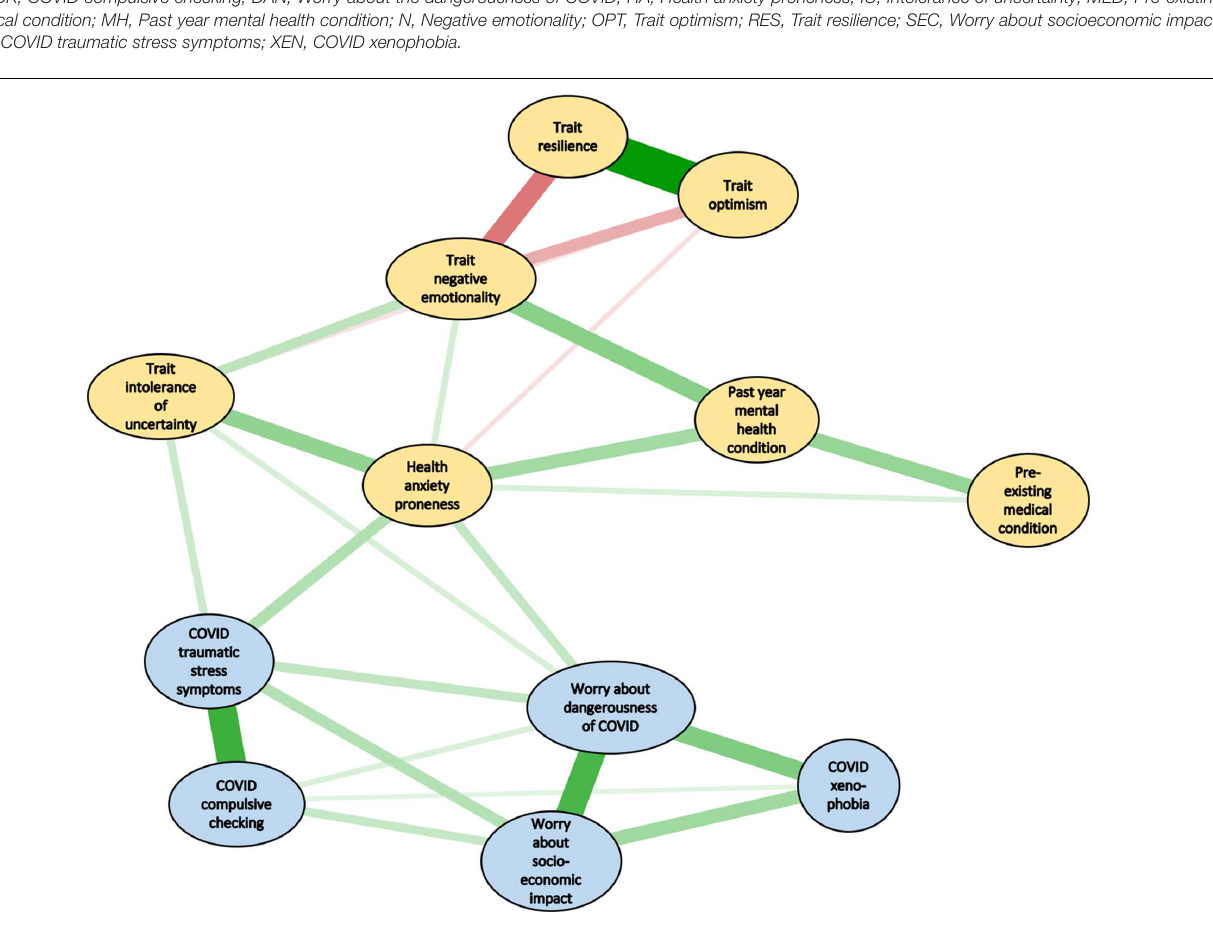
FIGURE 1 | Network analysis of vulnerability variables (yellow ellipses) and symptoms of the COVID Stress Syndrome (CSS) (blue ellipses). The size and thickness of lines indicate the degree of strength of connections. Green lines indicate positive connections (i.e., positive regularized partial correlations), whereas red lines indicate negative